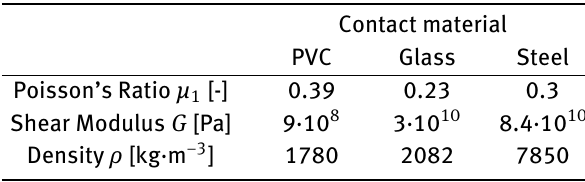
Table 4: Input parameters detected by laboratory measurement for EDEM Academic Interaction with: